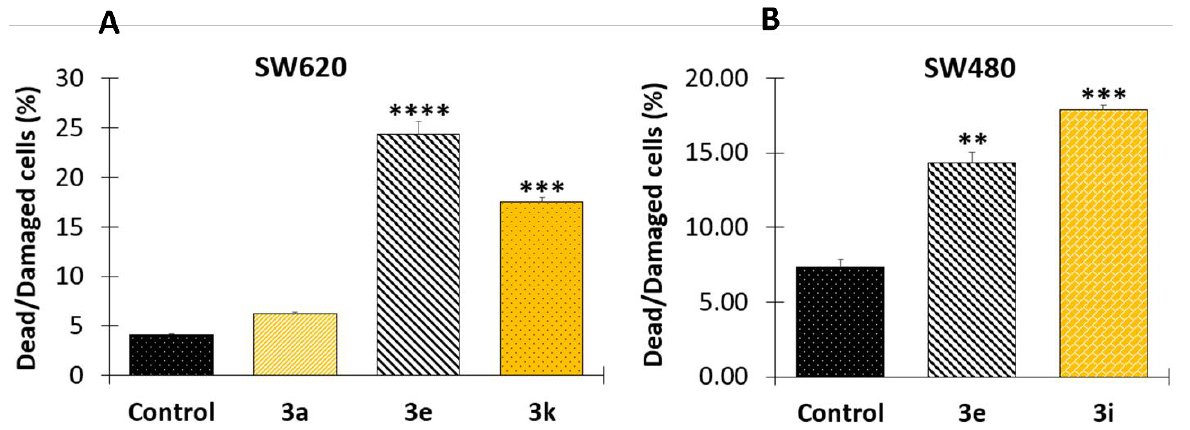
Figure 6 . Representation of data in bar chart form. Dead and damaged cells which lost membrane integrity (Q1 + Q2). SW620 ( A ); SW480 ( B ). p values lower than 0.05 were considered statistically significant (** p < 0.01); *** p < 0.001; **** p < 0.001) .